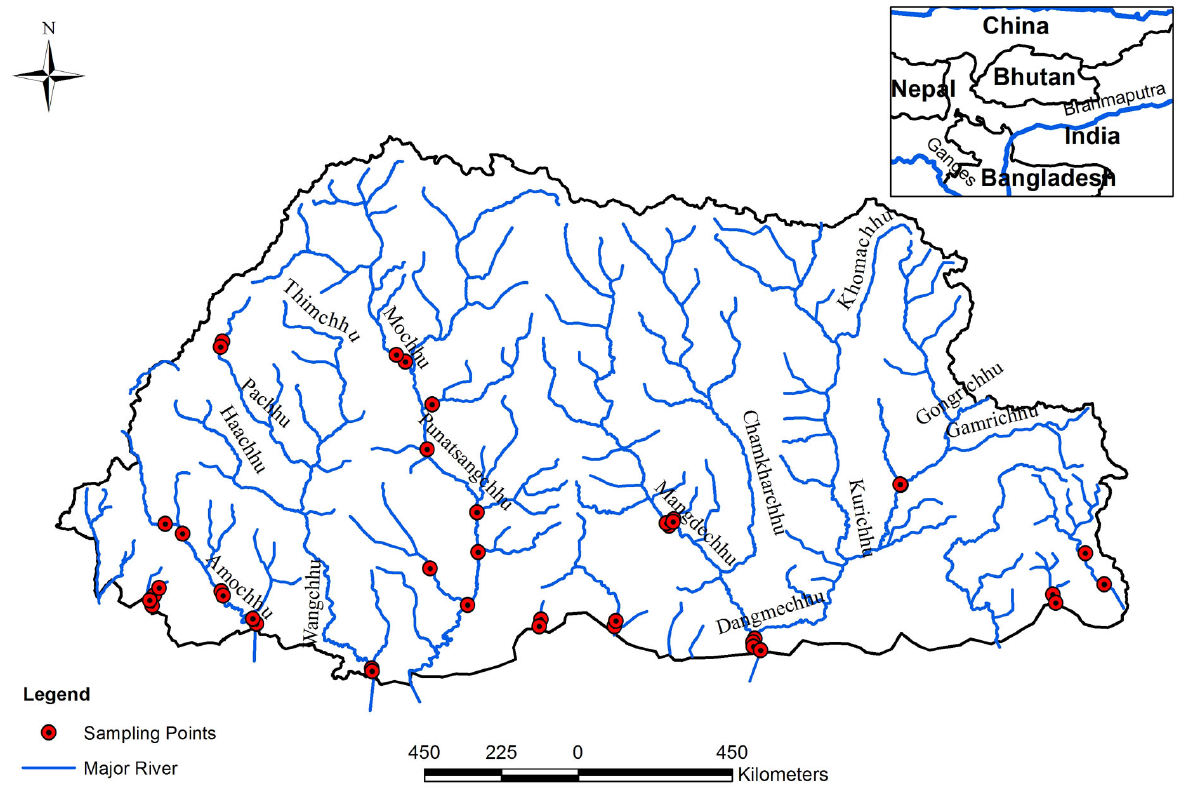
Figure 1. Map of study